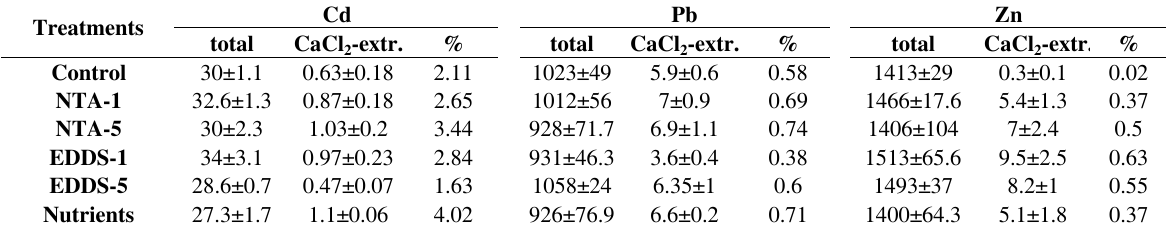
Table 2 . Total and CaCl 2 -extractable Cd, Pb and Zn (mg kg –1 ) after maize harvest. The results are presented as the mean and stan- dard errors ( n = 3) Cd Pb Zn Treatments CaCl 2 -extr. CaCl 2 -extr. CaCl 2 -extr. %